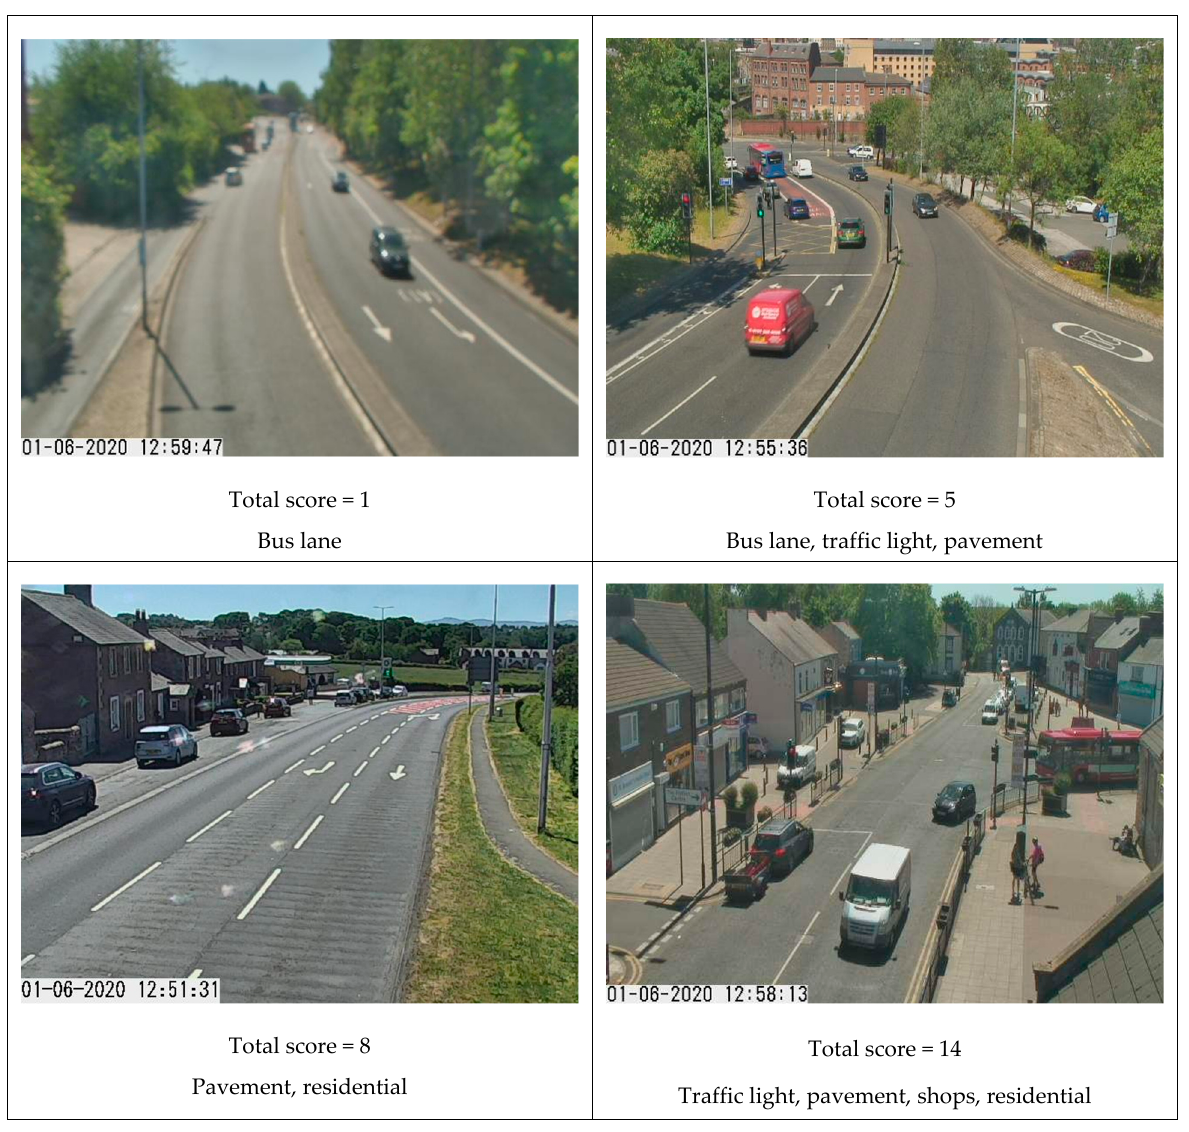
Figure 3. Selection of sample images from cameras with differing total ‘busyness’ scores (images captured 13:00, 1 June 2020) obtained from Tyne and Wear UTMC Open Data Service under Open Government Licence v3.0.